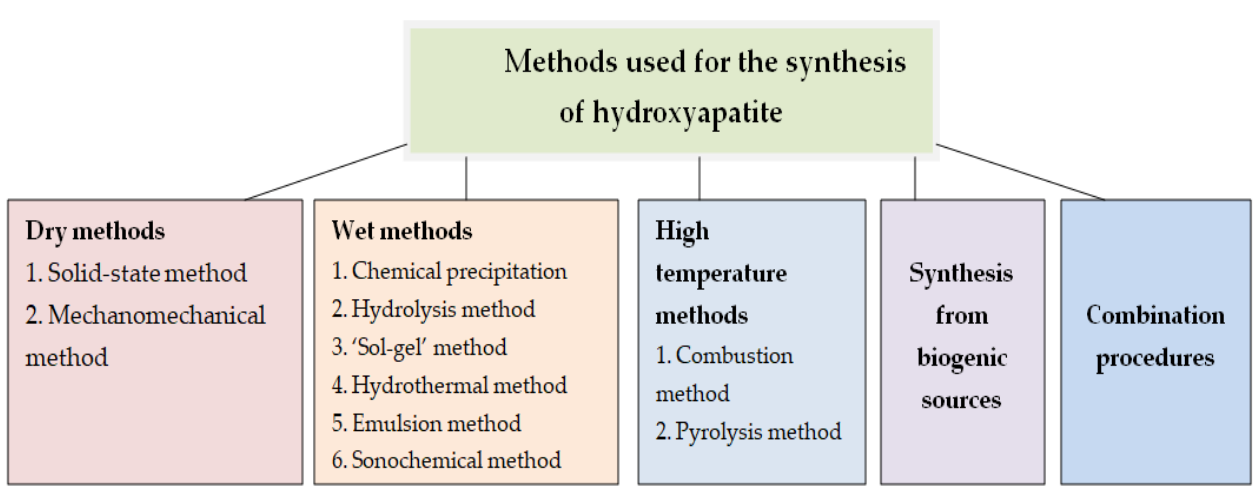
Figure 1. Classification of hydroxyapatite synthesis procedures (Reprinted from Advances in Colloid and Interface Science, 249 , Aleksandra Szcze´s, Lucyna Hołysz, Emil Chibowski, Synthesis of hydroxyapatite for biomedical applications, 321–330, 2017, with permission from Elsevier).